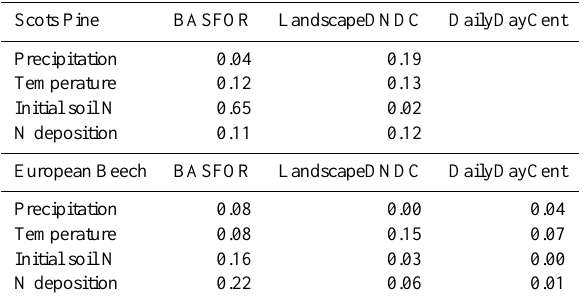
Table 2. R 2 of linear regressions for NPP of Scots pine and Euro- pean beech